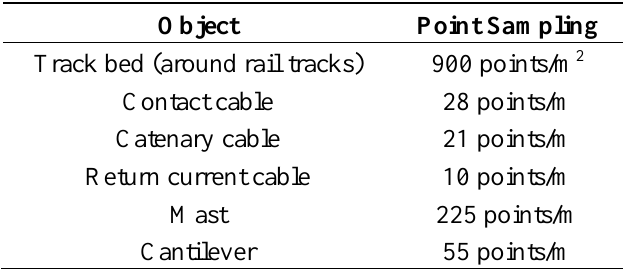
Table 2. Point sampling on various components of railroad infrastructure.